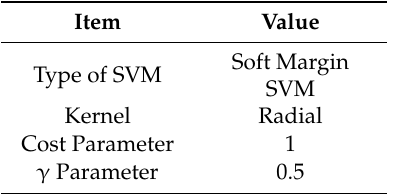
Table 2. Parameters of the support vector machine (SVM).